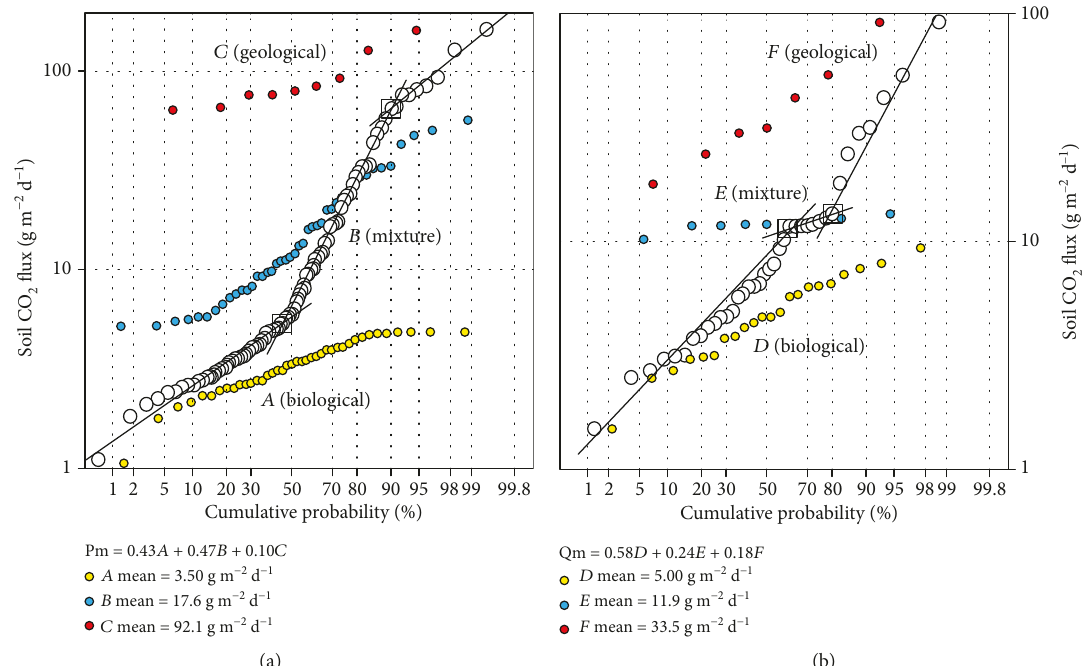
fl uxes in the whole WMVF (a) and SE slope of the Laoheishan volcanic cone (b). 2